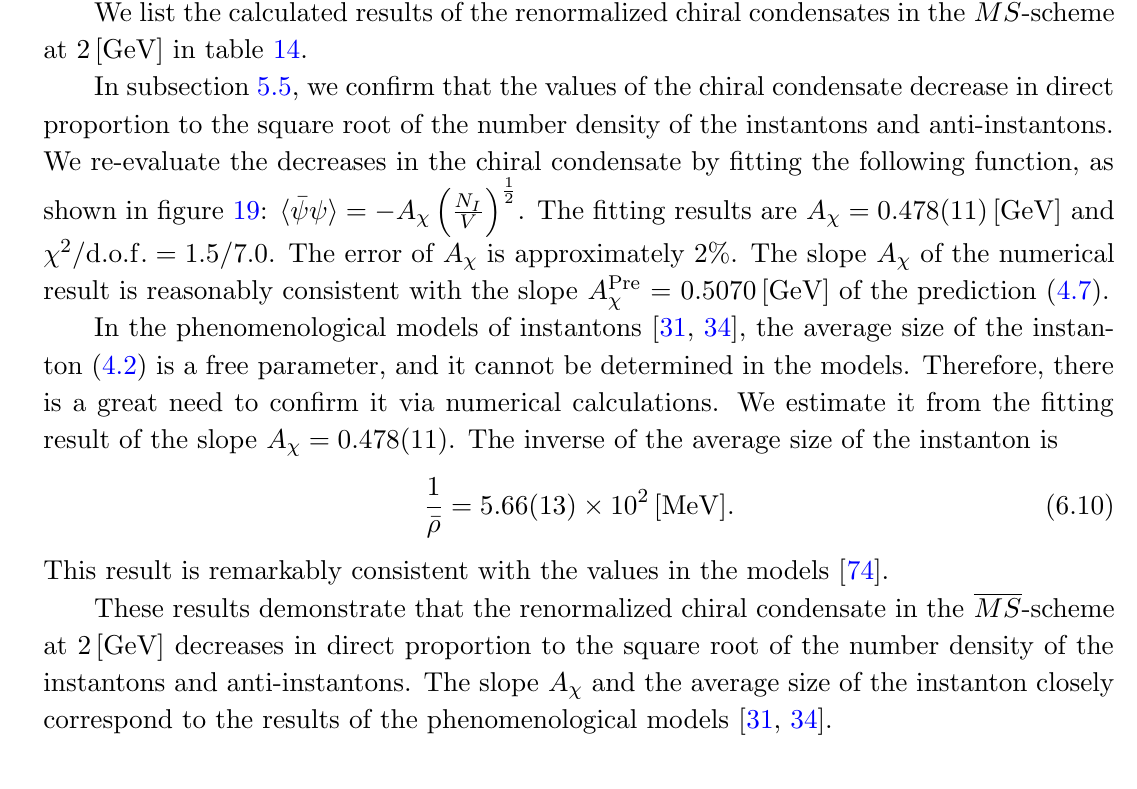
This result shows that there are no e(cid:11)ects of discretization. We will report this result in the future